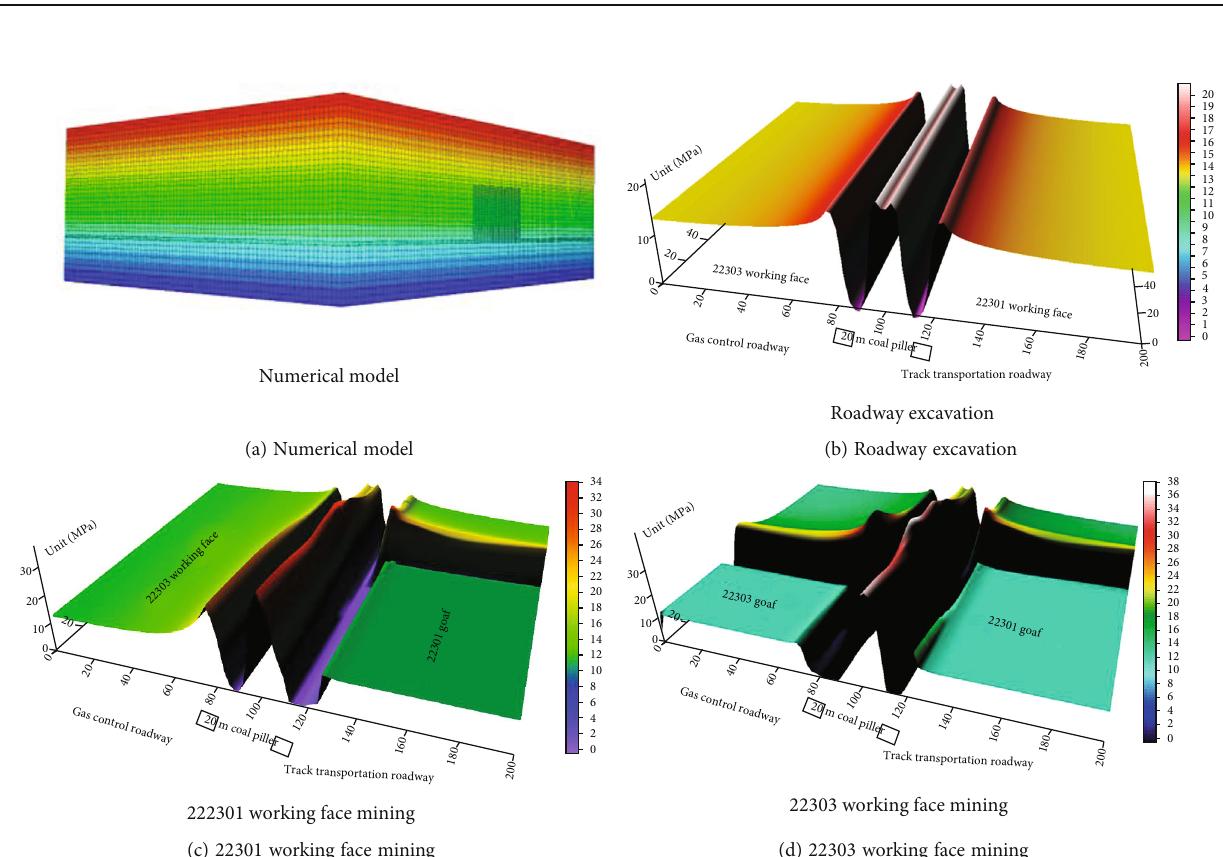
Figure 6: Numerical model of multiple dynamic pressure disturbances and vertical stress distribution.